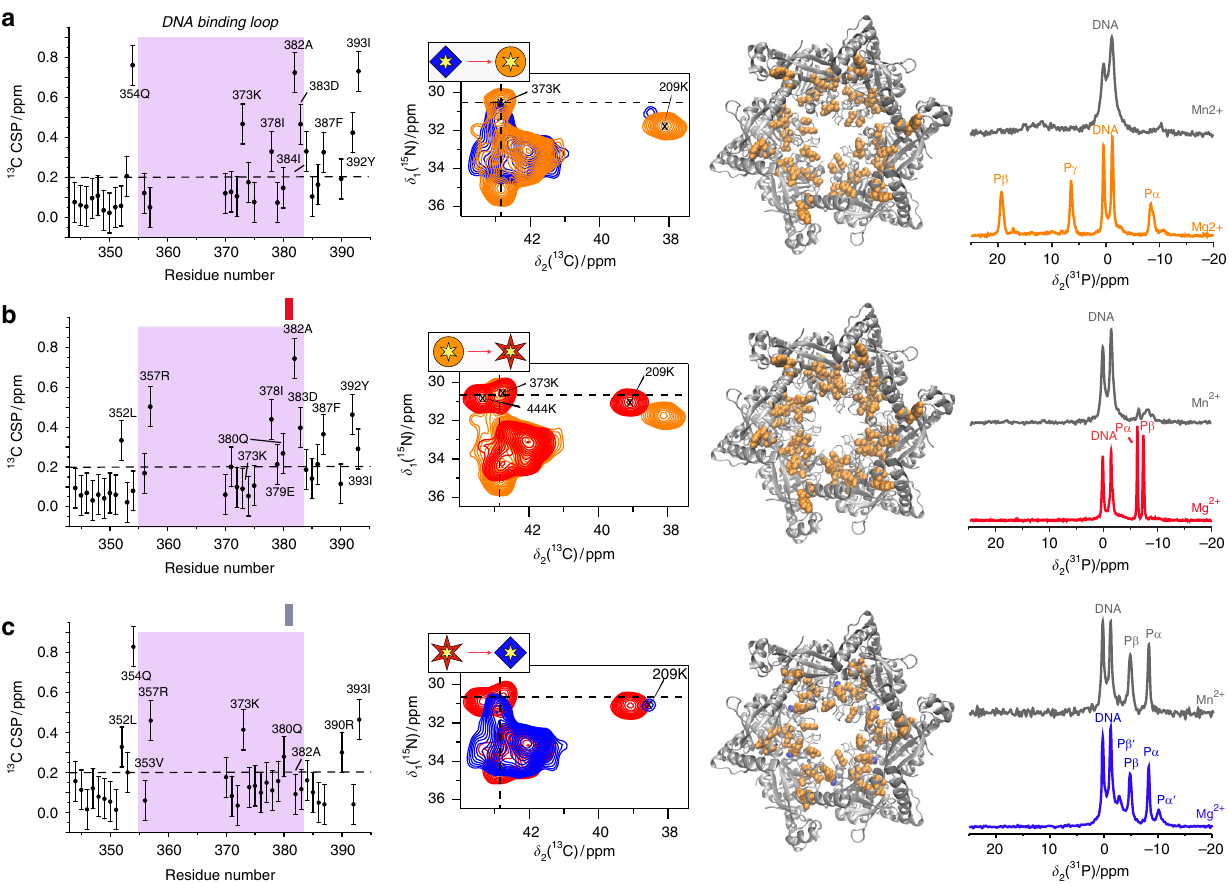
Fig. 4 NMR allows to identify speci fi c residues involved in DNA translocation. The fi rst column shows the 13 C C α -C β CSPs for the indicated steps of the DNA translocation process (residues 344 – 393 are shown), the DNA-binding loop is highlighted in purple. The error bars (identical for all residues) are estimated to 0.1 ppm from the differences in the experimental spectra. 15 N, 13 C correlation spectra (second column) for the lysine sidechains of the DNA-bound states for the three ATP-analogues as indicated. The third column shows a plot of the residues shown in the fi rst column and experiencing CSPs > 0.2 ppm (orange) on a structural model based on pdb accession code 4ZC0. Red and steel blue colours indicate appearing and disappearing residues, respectively (see Supplementary Table 6 for a list). Residues with CSP < 0.2 ppm are not coloured. Right column: 31 P spectra of the DNA-bound complexes using Mg 2 + and Mn 2 + as metal ion cofactors indicating if the metal is bound (extinction of the ATP-analogue resonances for Mn 2 + ), or not (no change upon metal substitution). All source data for the chemical-shift values of columns 1 and 3 are listed in the Source Data fi